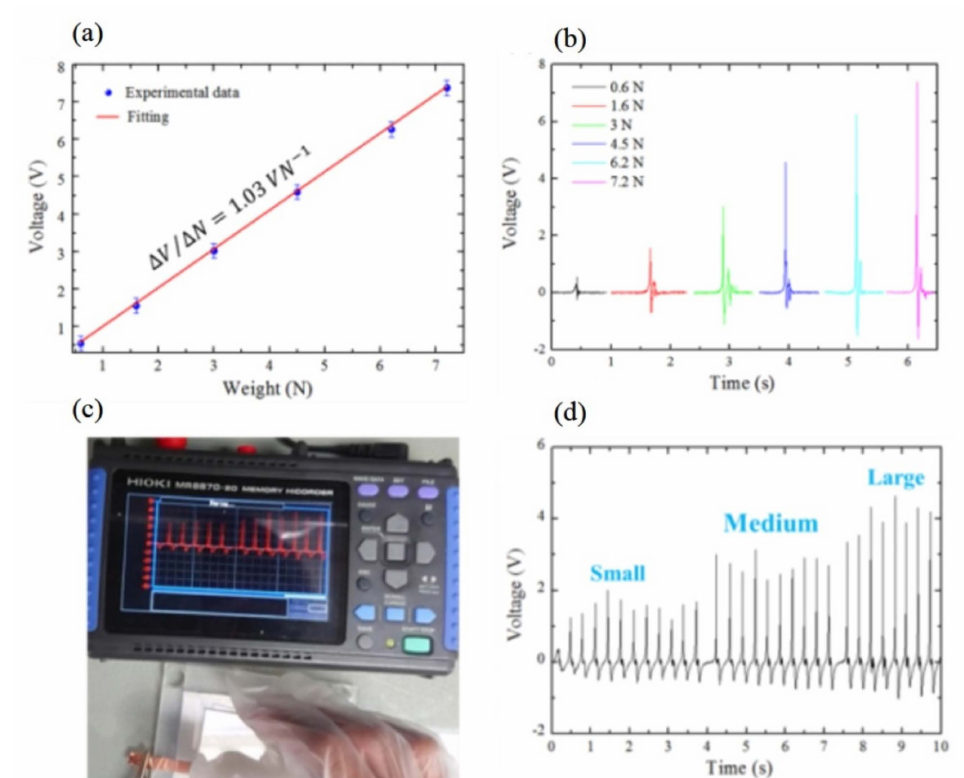
Figure 32. The OL-DTH-MN applied to the weight and pressure sensors: The output voltage of sensors as a function of ( a ) weight; ( b ) the output voltage under a wide range of load weights of 0.6 to 7.2 N; verification of the force sensor under three relative zones of load forces namely small (1.96 N), medium (3.05 N), and large (4.5 N) for the corresponding voltage response: ( c ) The image of OL-DTH-MN through external force by continuous hand tapping, and ( d ) the output voltage for estimating the corresponding